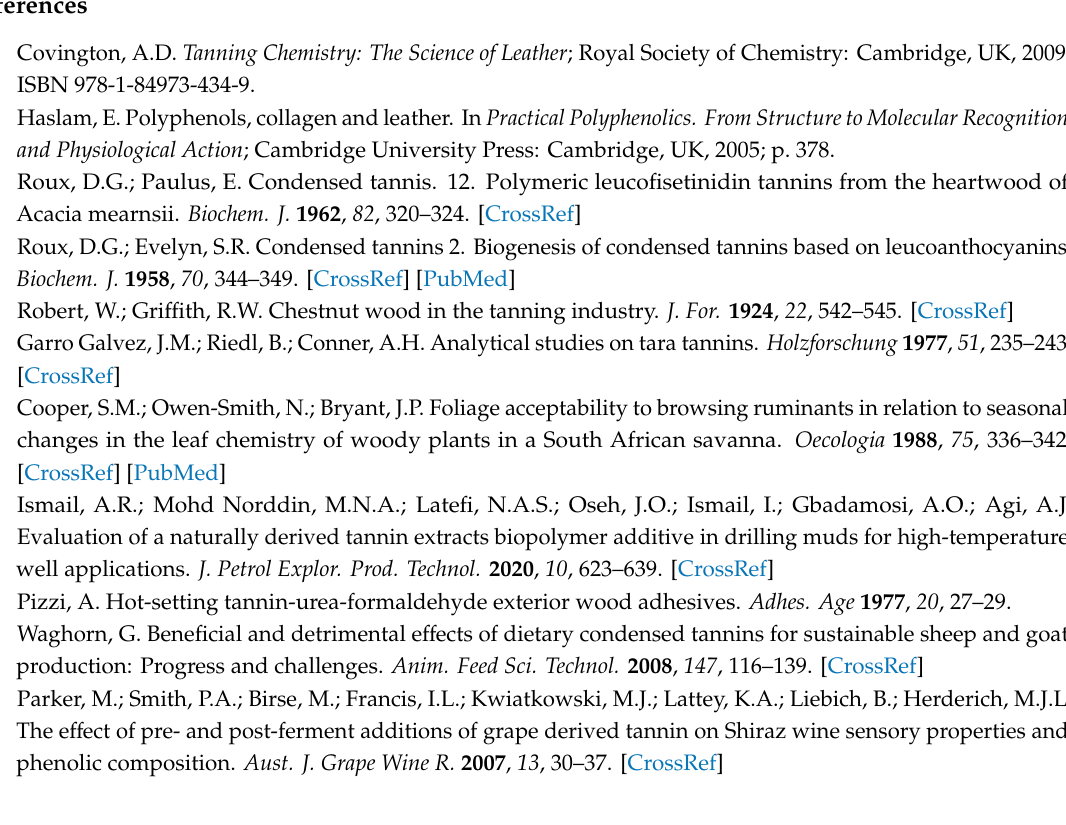
Table S1: Experimental and calculated 1 H and 13 C NMR shifts for compound 2 , Table S2: Experimental and calculated 1 H and 13 C NMR shifts for compound 4 , Table S3: 1 H (600 MHz, MeOD, 20 ◦ C) and 13 C NMR data (150 MHz, CD 3 OD, 20 ◦ C) of 2 R ,3 R ,4 S -catechin-4 β -sulfonic acid ( 8 ). Figure S1: 1 H NMR of sulfited catechin 2 , Figure S2: 13 C NMR of sulfited catechin 2 , Figure S3: 1 H NMR of sulfited epicatechin 4 , Figure S4: 13 C NMR of sulfited epicatechin 4 , Figure S5: 1 H NMR of C-4 sulfited catechin 8